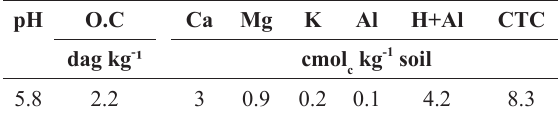
Initial fertility of the soil used as substrate in the assays with corn, soybean, and sugarcane.